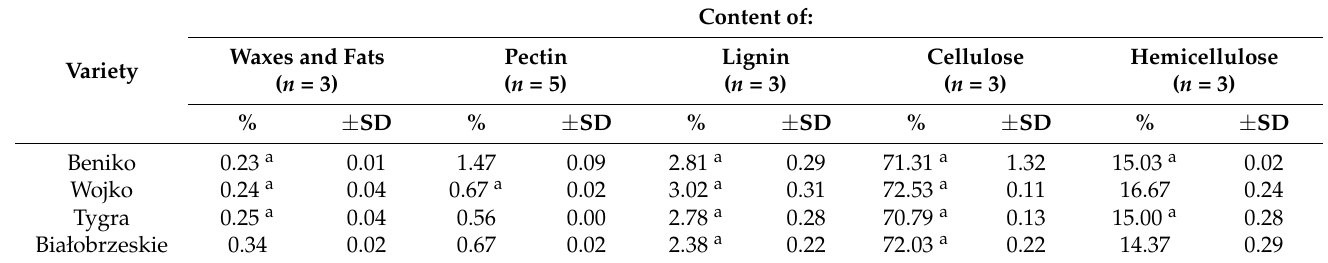
Table 2. Diversity of chemical composition of fibres extracted from different hemp varieties with use of water retting: Beniko, Wojko, Tygra and Białobrzeskie. Results are expressed as mean ± standard deviation (SD). Lowercase letters indicate significant differences at p ≤ 0.05 according to the Tukay’s HSD test [30].